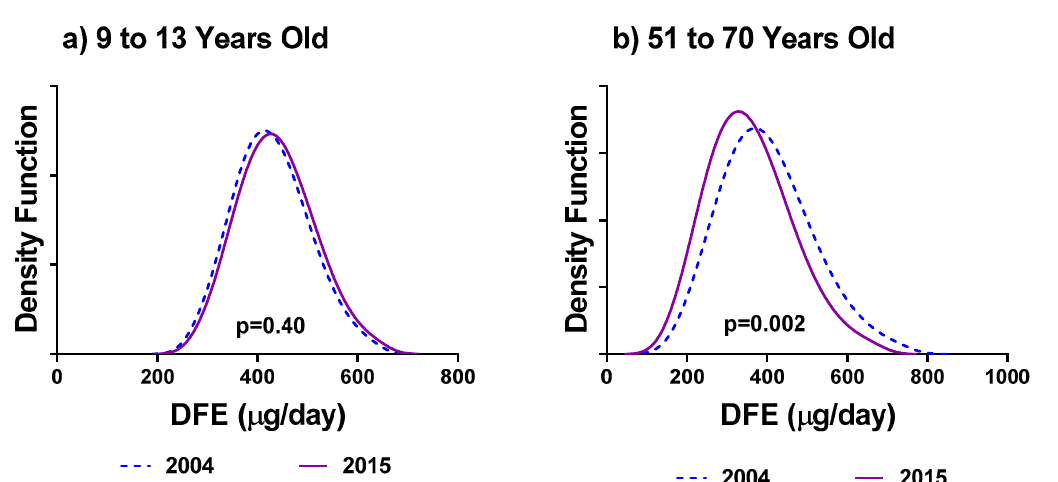
Figure 1. Comparison of estimates of usual intake distribution of dietary folate equivalents (DFE) ( µ g / day) between 2004 and 2015 for ( a ) females 9–13 years old; and ( b ) females 51–70 years old.